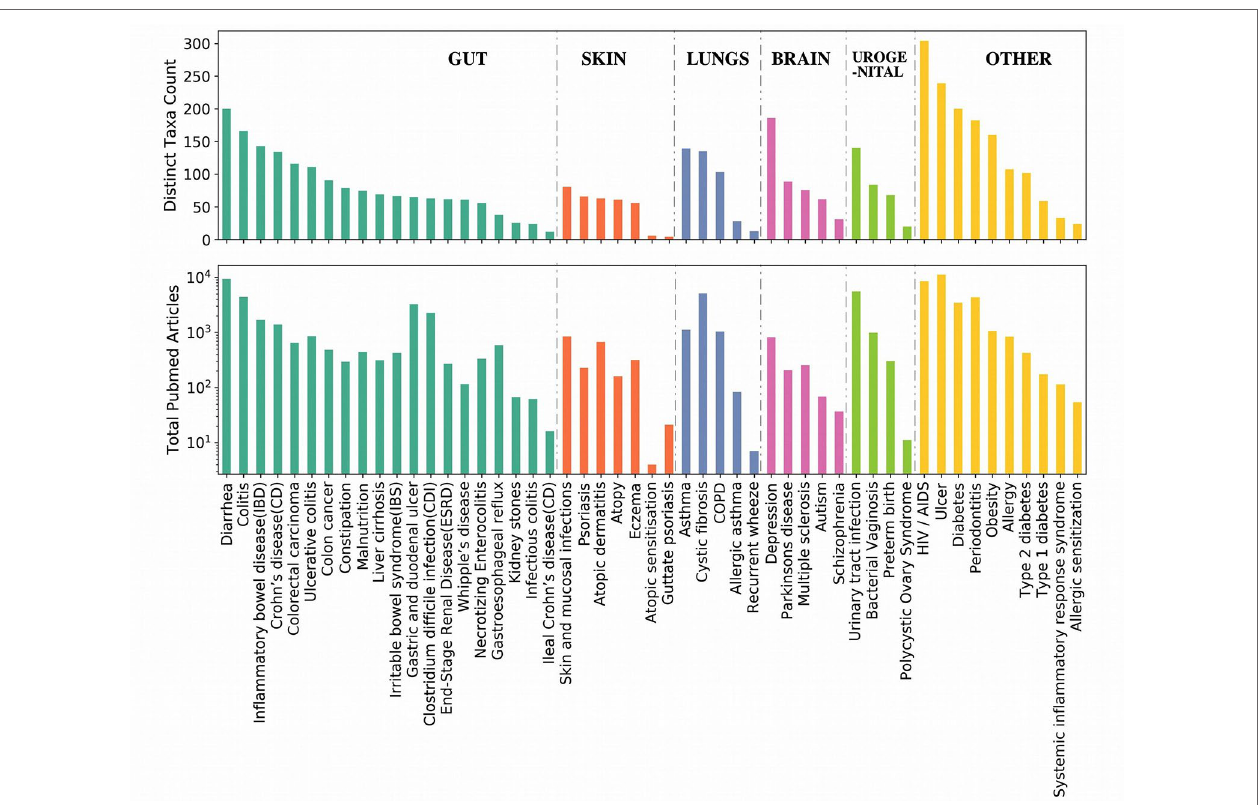
FIGURE 3 | Summary of the associated microbial genera count corresponding to each disease and the number of articles reporting the disease. The diseases are ordered based on the categories as listed in Table 1 . Each category of disease is sorted based on the number of genera